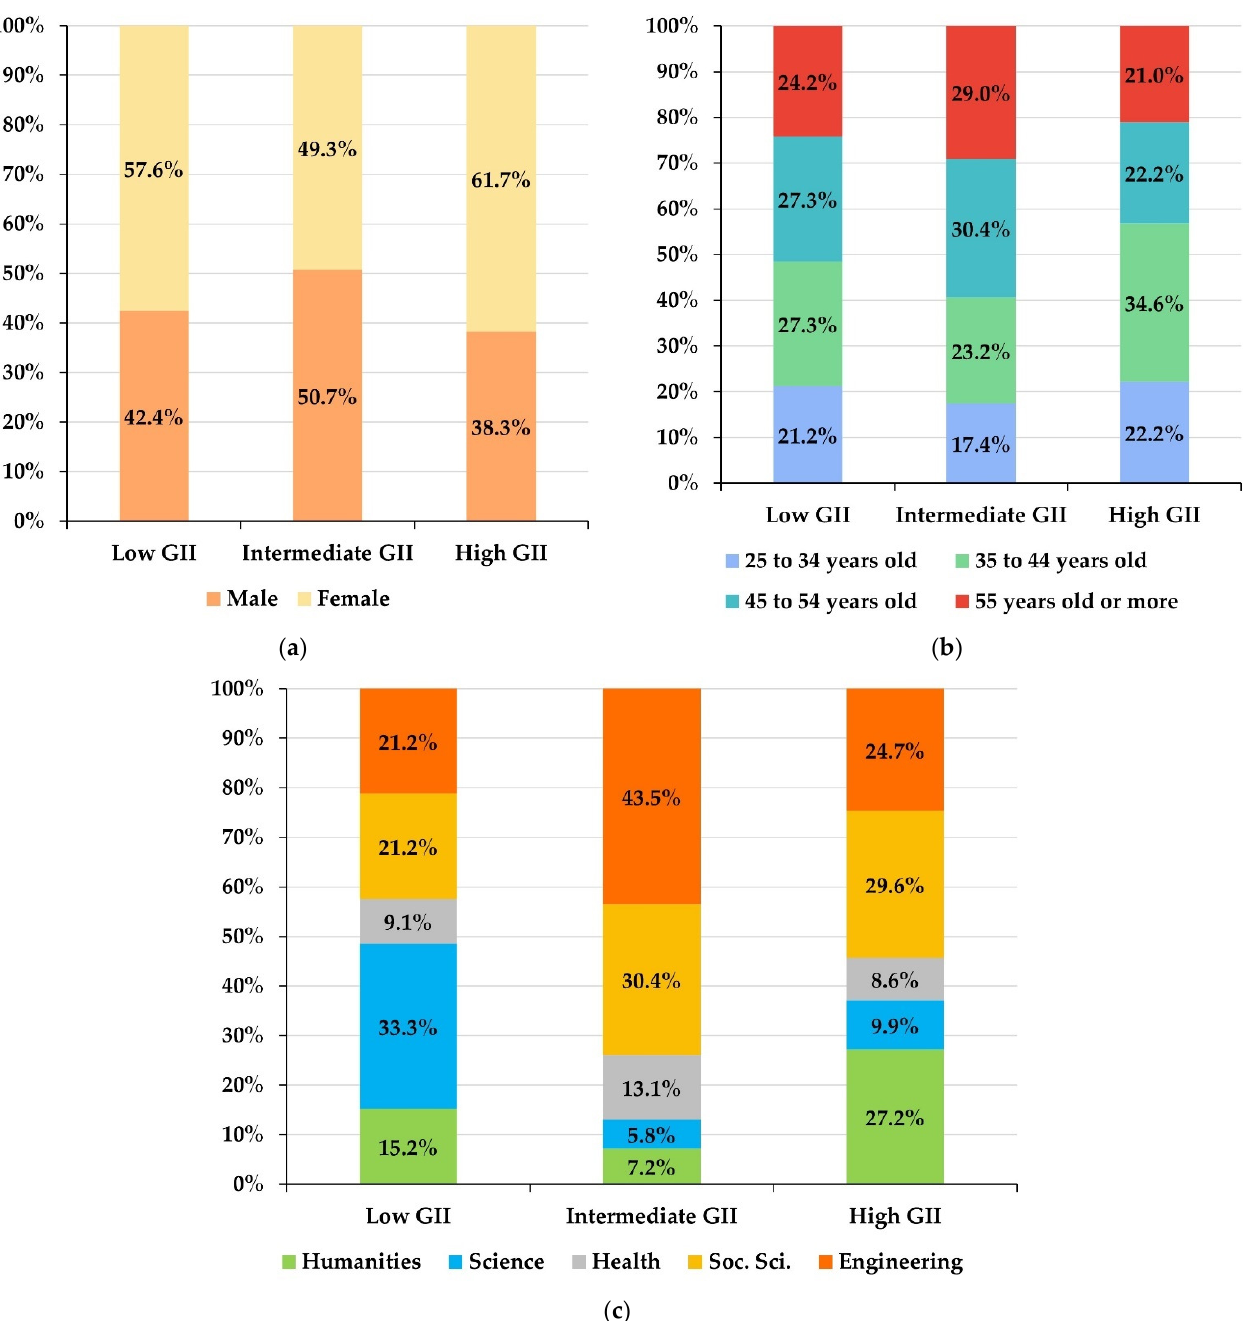
Figure 3. Distributions of the sample when the participants are differentiated by GII area and the rest of the independent variables: ( a ) by gender; ( b ) by age range; and ( c ) by area of knowledge.